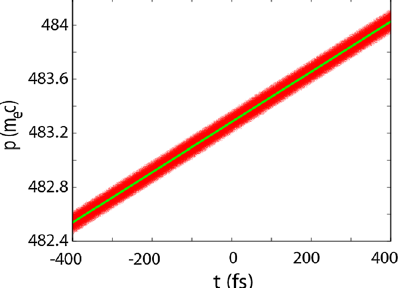
FIG. 3. Longitudinal phase space (time momentum) of the central part of the beam before (green) and after (red) TGU1.